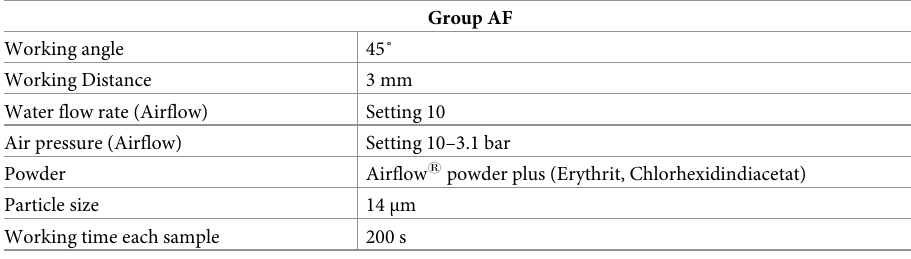
Table 1. Standardized settings for group